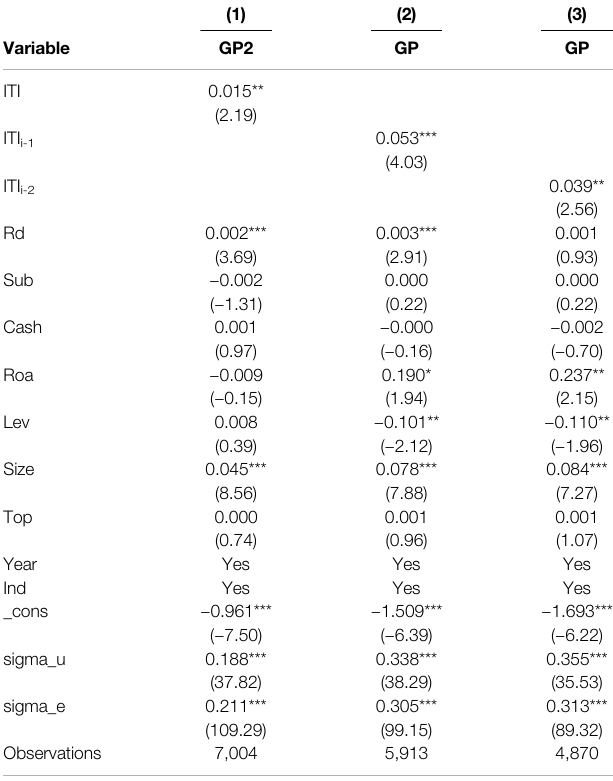
TABLE 5 | Robustness test: alternative proxies for green innovation and IT investment. (1) (2)